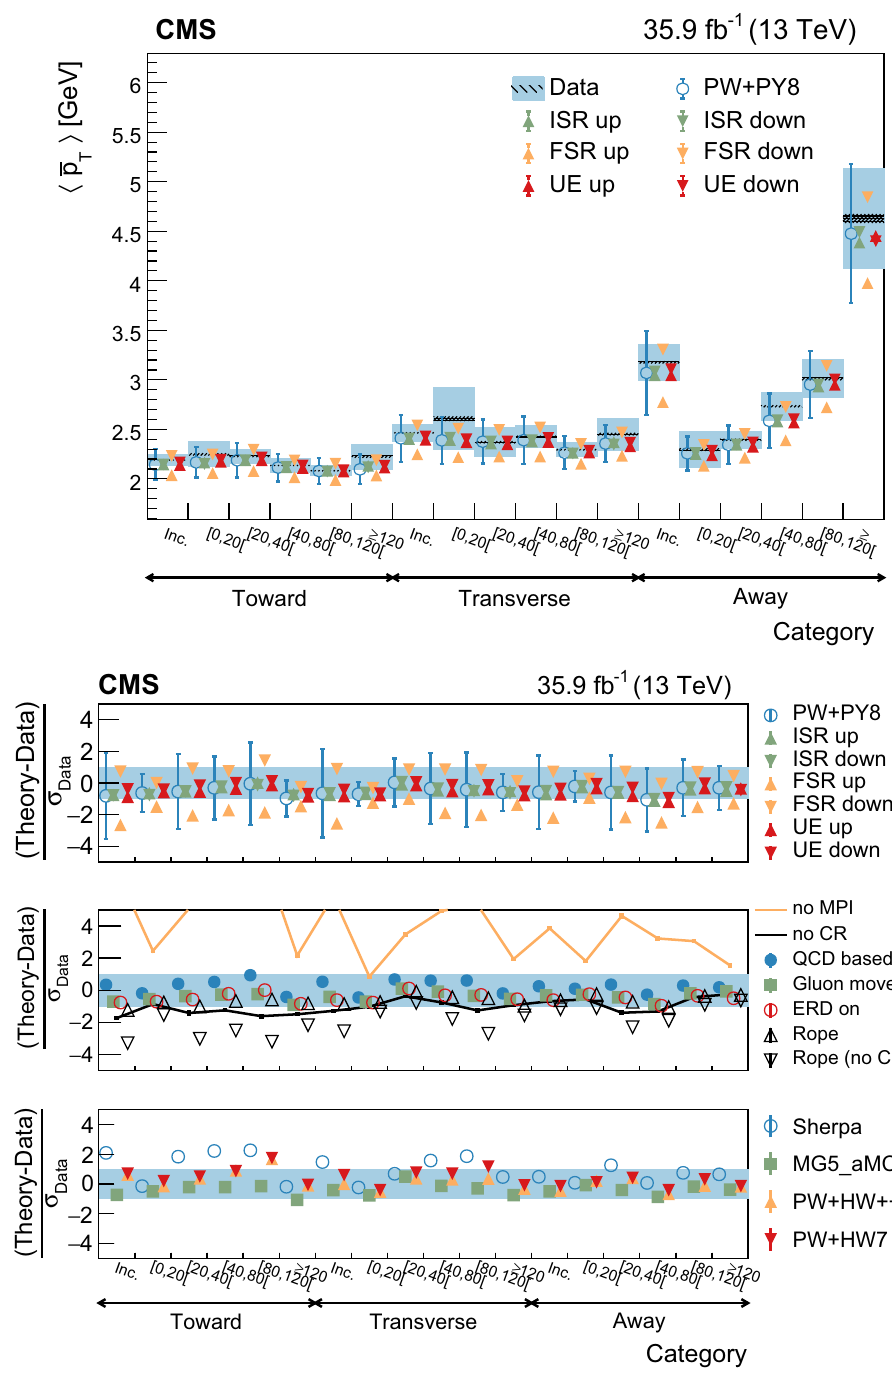
Fig. 24 Average p T in different p T ((cid:6)(cid:6)) categories. The conventions of Fig. 14 are